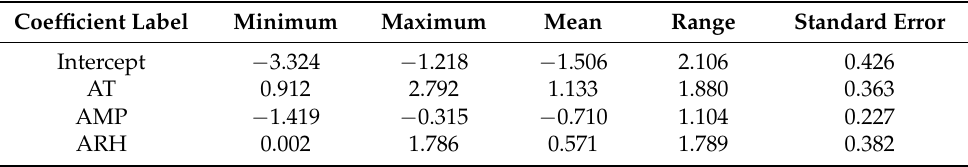
Table 4. Summary statistics of the varying (local) coefficients.